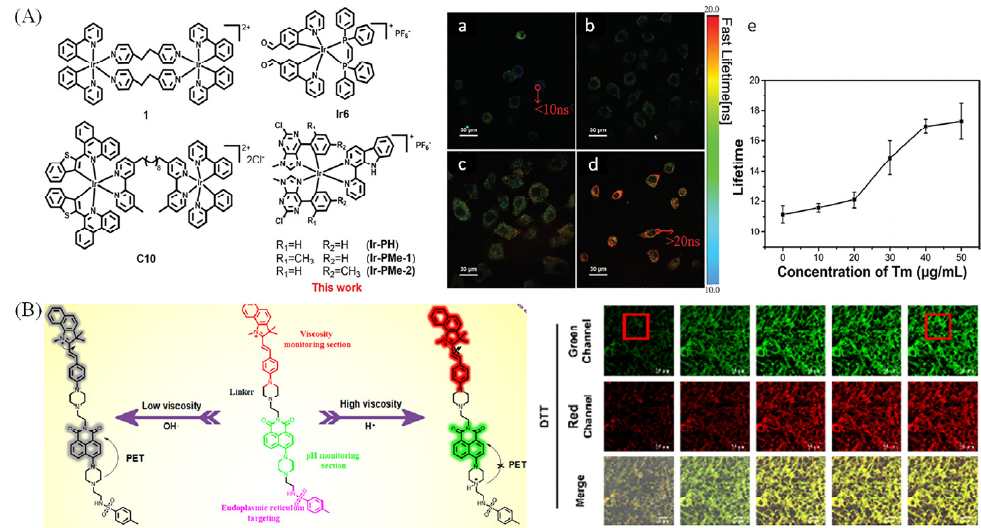
Figure 13. ( A ) Chemical structures of viscosity-sensitive iridium (III) complexes and the FLIM pictures of A549 cells stained with Ir − PH treated with Tm (0, a ; 20, b ; 30, c ; 50, d ; mg/mL); ( e ) the lifetime of cells under diverse concentration of Tm. Reproduced from 66 with permission of the Royal Society of Chemistry, copyright 2021. ( B ) The mechanisms of DSPI-3 sensitive to viscosity and pH, and dual-color visualize cells by dithiothreitol (DTT). Reproduced from [67] with permission of the American Chemical Society, copyright